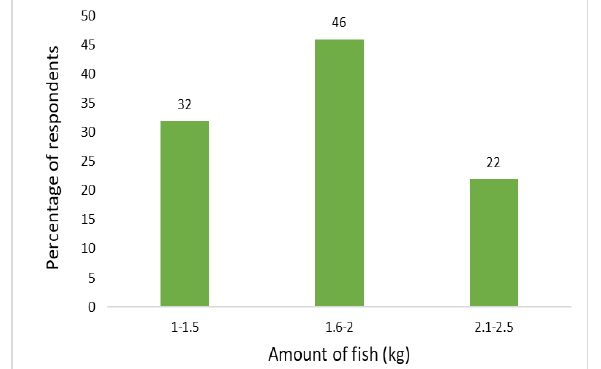
Figure 3: Amount of fish harvested by the fishers (kg/day/fisher) in the study area Figure 4: Percentage of major fish groups of the Padma river Few species, such as Catla ( Catla catla ), Rui ( Labeo rohita ), and Hilsha ( Tenualosa ilisha ), were extremely prevalent among the 33 species of fish Various kinds of fish were captured by fishers in the Padma River and crustaceans found in this river. The availability of some fish species throughout the research period, including Carps, Barbs, Clupeids and was reasonable while others such as Pangus were quite rare ( Pangasius Minnows, Catfish, Perch, Snakehead, Eels and Crustaceans which pangasius ). There are 33 fish species identified in the Padma River which constituted 31%, 12%, 18%, 18%, 9%, 6%, and 6%, respectively (Figure have been displayed in Table 2. 4). Table 2: List of Fish Species as Recorded During The Study Period in The Padma River Order Family Local